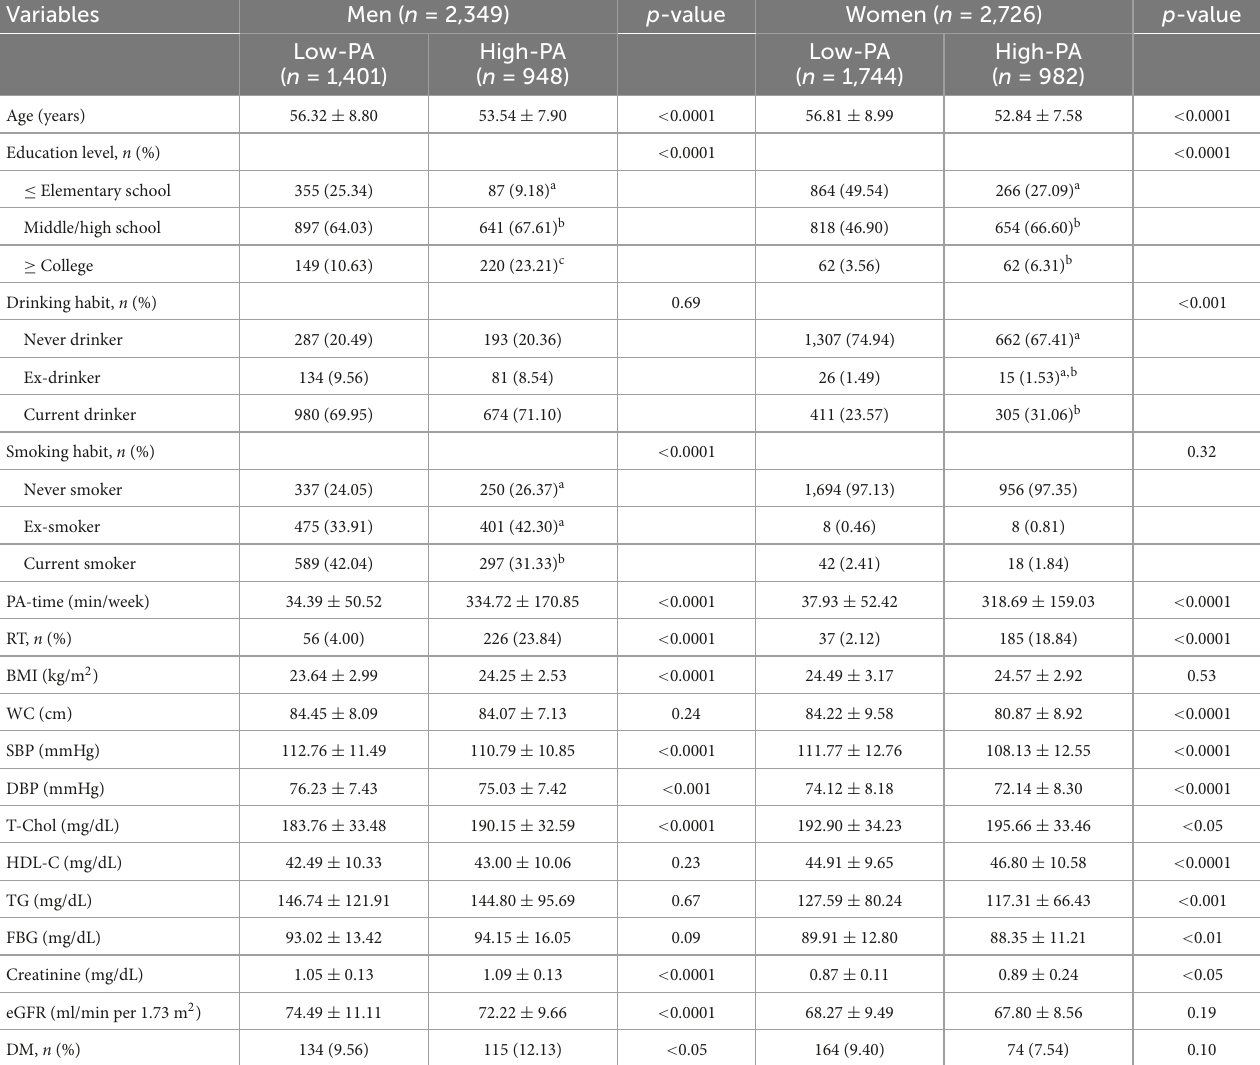
TABLE 1 Baseline characteristics of study participants stratified by leisure-time physical activity (PA) levels.